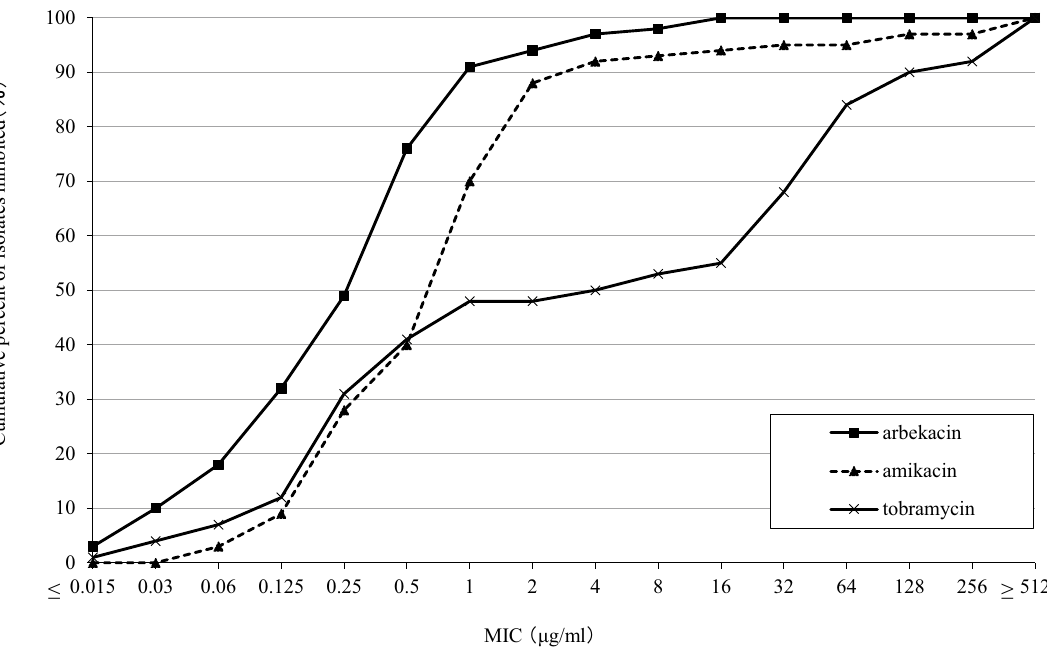
Figure 2. MIC distributions of arbekacin, amikacin and tobramycin against 100 Nocardia